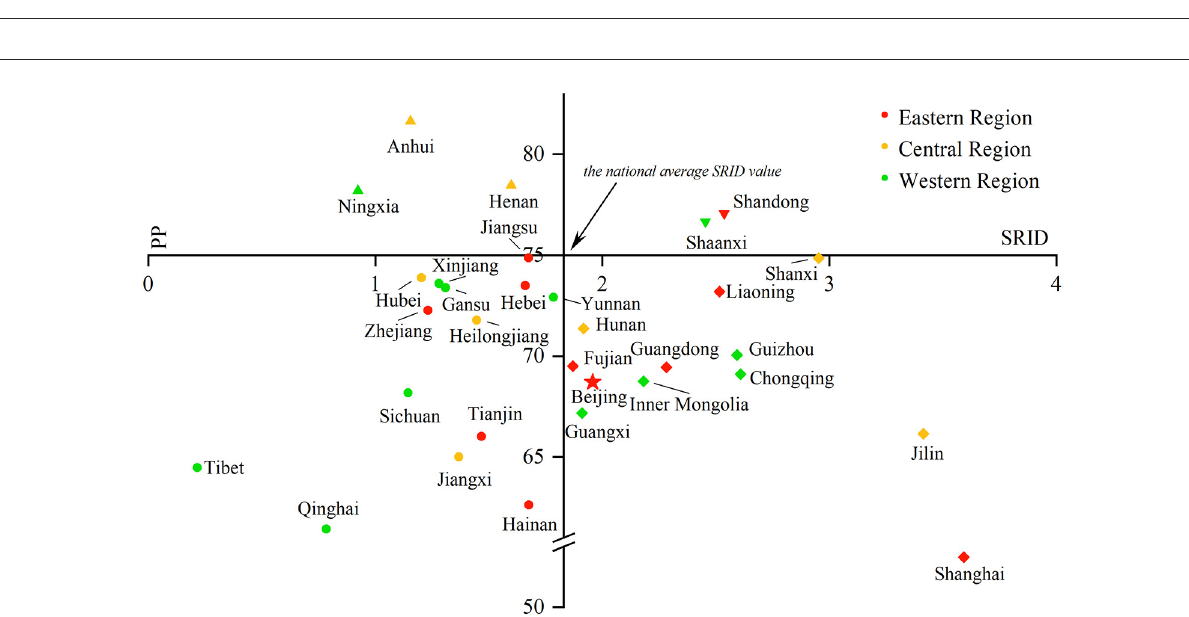
FIGURE8 Scatter plot with four quadrants for the proportion of professionals in 2019.